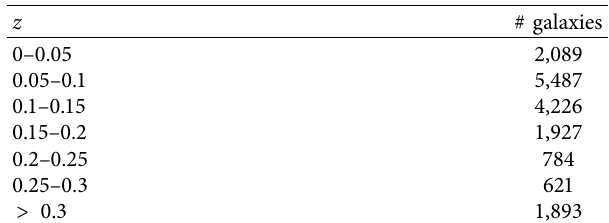
Table 3: The number of DECam galaxies in different redshift ranges. The distribution is determined by a subset of 17,027 galaxies included in the 2dF data